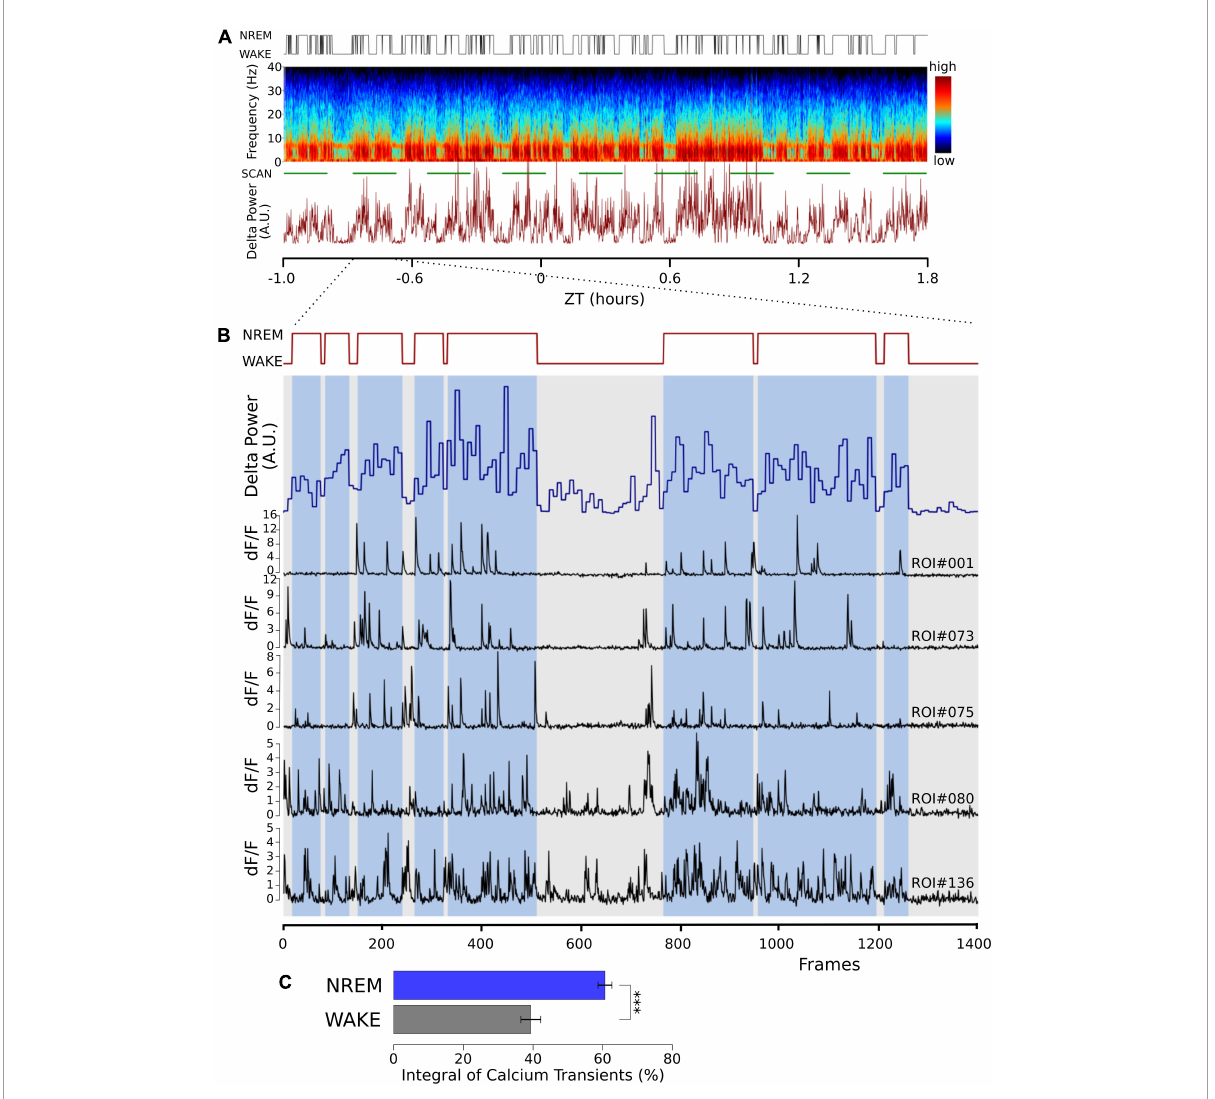
FIGURE1 Cortical calcium transients during waking and NREM sleep. Somatic calcium transients are larger in NREM sleep compared to waking in simultaneous EEG and EMG recordings and in vivo two-photon GCaMP6f calcium imaging. (A) Sample of one recording session. Top trace: hypnogram derived from the simultaneously recorded EEG and EMG. Middle graph: Pseudo-colored spectrogram of the EEG recording. The green line below indicates the time during which the imaging data was obtained (SCAN). The graph below shows power in the EEG delta band (0.5–4 Hz) over time. (B) Enlarged time window from panel (A) (indicated by the dotted lines), representing one imaging episode of 1,400 frames lasting 11 min. Top trace: Hypnogram, times in NREM sleep are marked with blue bars, showing two long wake episodes. Blue trace: EEG delta power in 4 s epochs. Black traces: sample of dF/F traces from five different regions of interest (ROI), drawn over somata of layer II/III excitatory neurons. Notice the decrease in activity during the wake episodes. (C) Average data from a total of 100 neurons in 3 mice are shown (mean ± SEM). The dF/F traces were thresholded at 0.5 for all ROIs (see section “Materials and methods”), and the integral over the threshold was calculated. Given the calcium fluorescence variability between ROIs, we calculated the activity in its percentage during NREM and its percentage during wakefulness, corrected by the relative durations of NREM and wakefulness. P values less than 0.001 are indicated with three